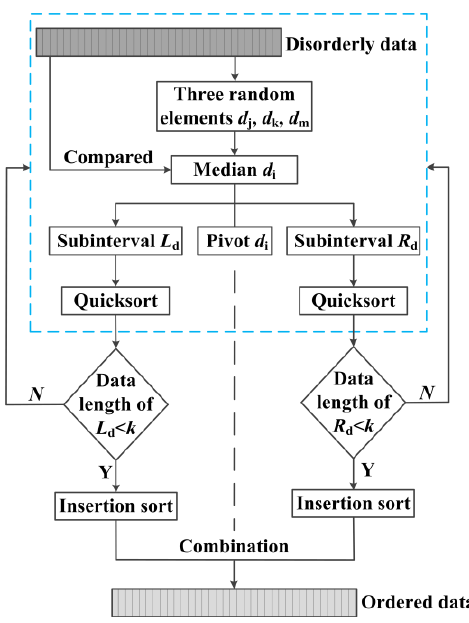
Figure 7. Flowchart of three-element median quicksort method.